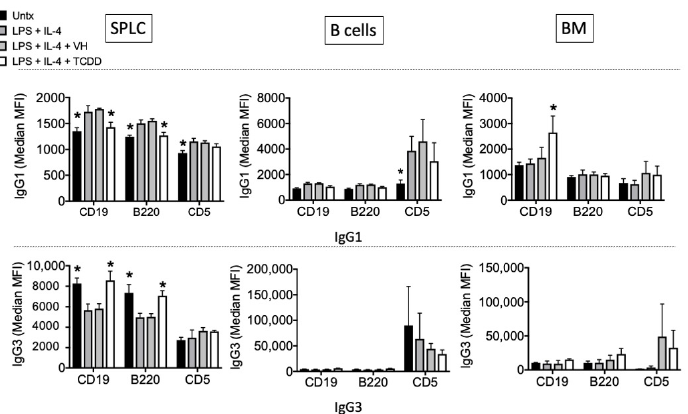
Figure 12. TCDD inhibited the MFI of IgG1 in SPLC. SPLC, B cells or BM cells were treated with VH (0.01% DMSO) or TCDD (30 nM) for 30 min then were stimulated with LPS + IL-4 (5 µg/mL + 10 (top, IgG1; bottom, IgG3; day 4 shown only). Cells were gated on live single lymphocytes. Bars represent mean ± SD from triplicate samples. Untx, untreated; VH, vehicle. * p < 0.05 as compared to respective LPS + IL-4 + VH control within B cell marker. Data were obtained from one of the representative in